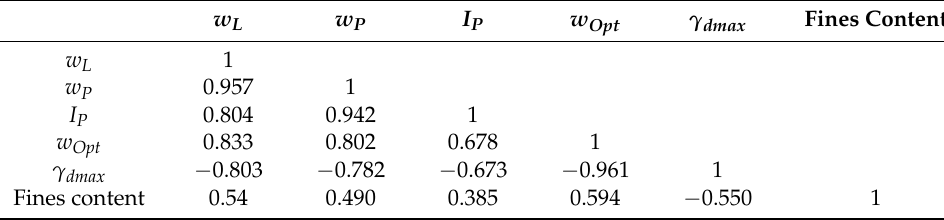
Table 2. Correlation matrix between different parameters. w L w P I P w Opt γ dmax Fines Content